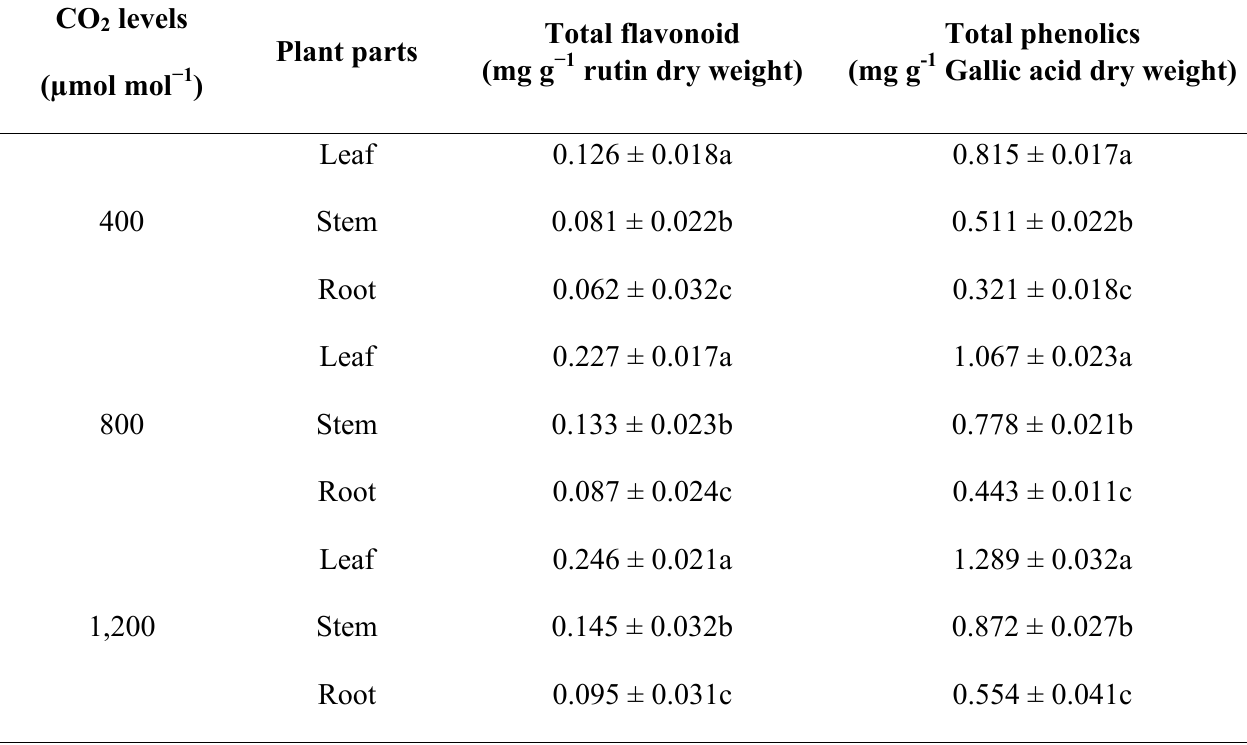
Table 1. Accumulation and partitioning of total flavonoids (TF) and total phenolics (TP) in different plant parts of Labisia pumila Blume under different CO